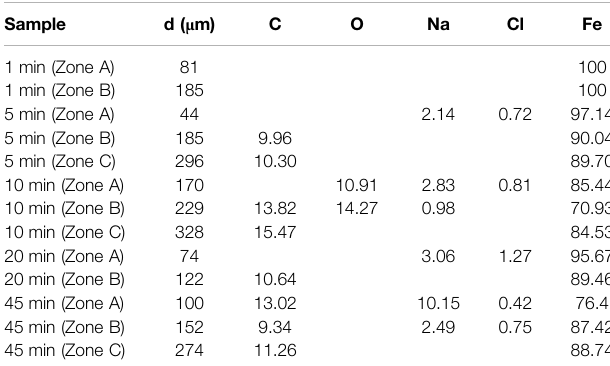
TABLE 1 | Chemical composition of different microdroplet domain zones by EDS, atomic number